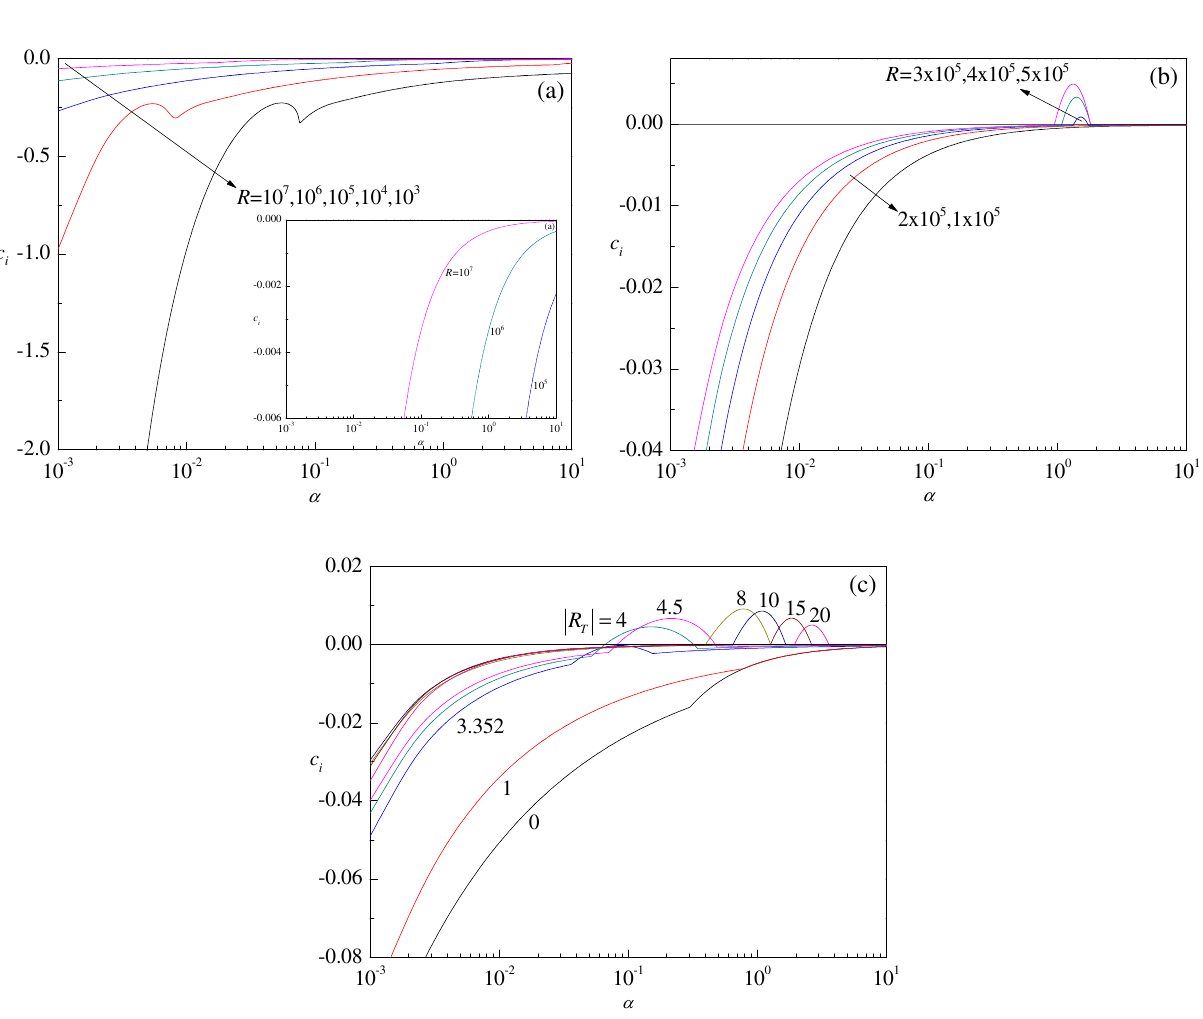
Figure 3. Plots of the growth rate c i versus wave number α for different values of (a) R with R T = 0 (absence of throughflow), (b) R with R T = 10 (presence of throughflow), and (c) | R T | with R = 10 6